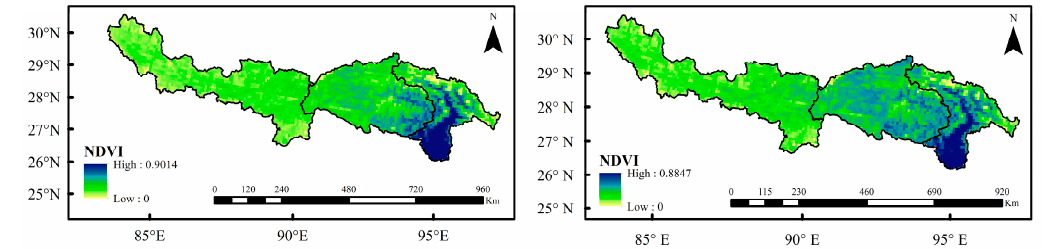
Figure 10. Annual ( left ) and growing season ( right ) spatial distributions of NDVI.